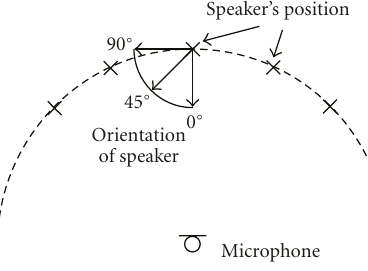
Figure 13: E ff ect of speaker orientation.